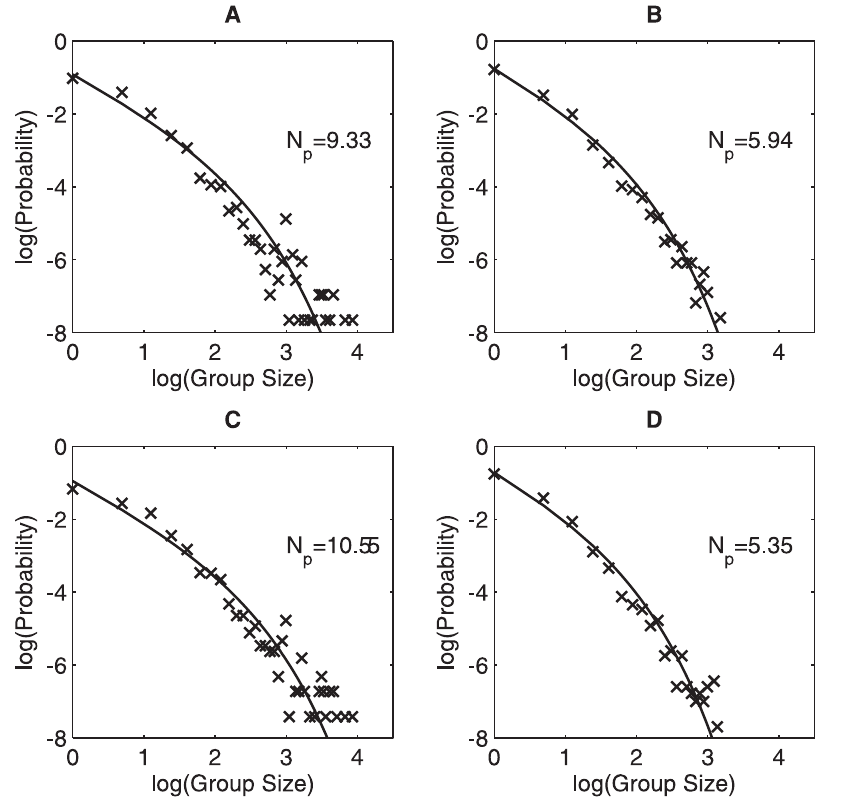
Figure 3. Effect of temperature and place on group-size distribution. Group-size distribution for initial morning temperatures below 6 u C (number of observations, n =2113) (A), initial morning temperatures above 6 u C ( n =3957) (B), for groups located in hedges or on food ( n =1668) (C) and for groups located elsewhere ( n =4402) (D).